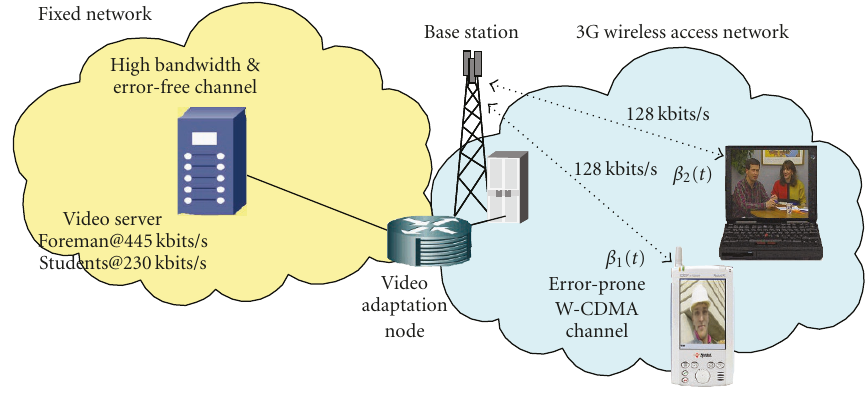
Figure 8: Experimentation scenario for the error-resilient video adaptation by